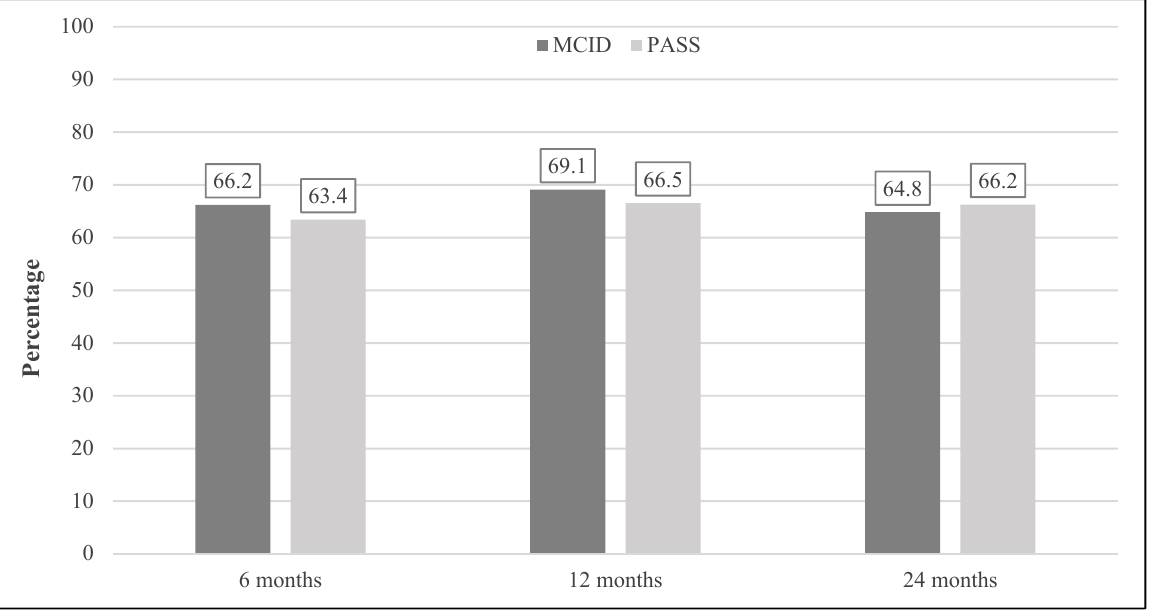
Figure 2. Pre- and postoperative course of the iHOT-33. Significant improvements in the mean outcome in the postoperative course compared to the mean preoperative score with each p < 0.001. iHOT-33, International Hip Outcome Tool (33 items).